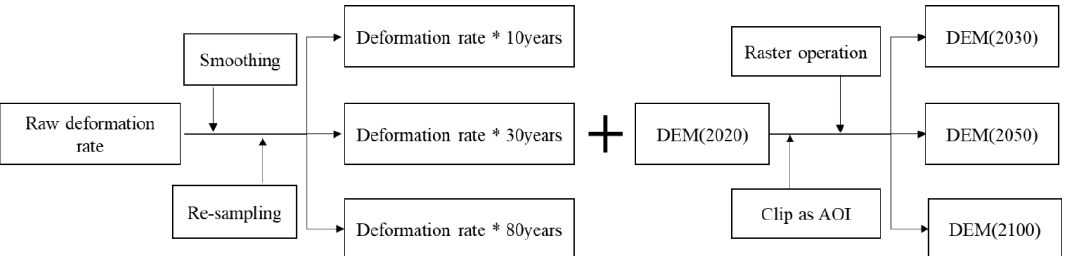
Figure 14. Schematic diagram of DEM simulation.